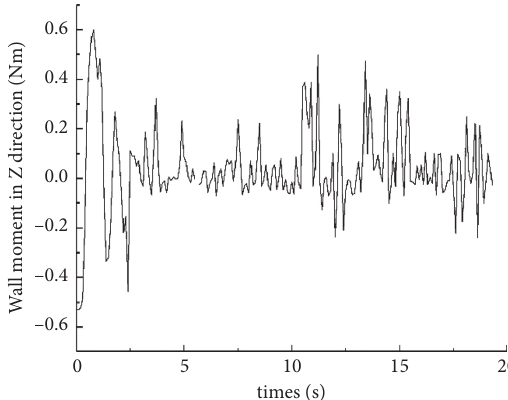
Figure 6: Central moment at the spray tank bottom surface in Z direction.